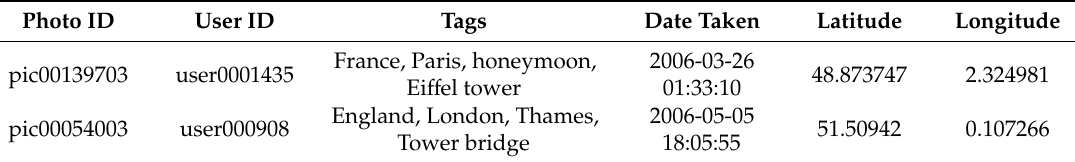
Figure 1. Samples of community-contributed geotagged photos (CCGPs). Table 1. Sample metadata of CCGPs; a few attributes are not shown.